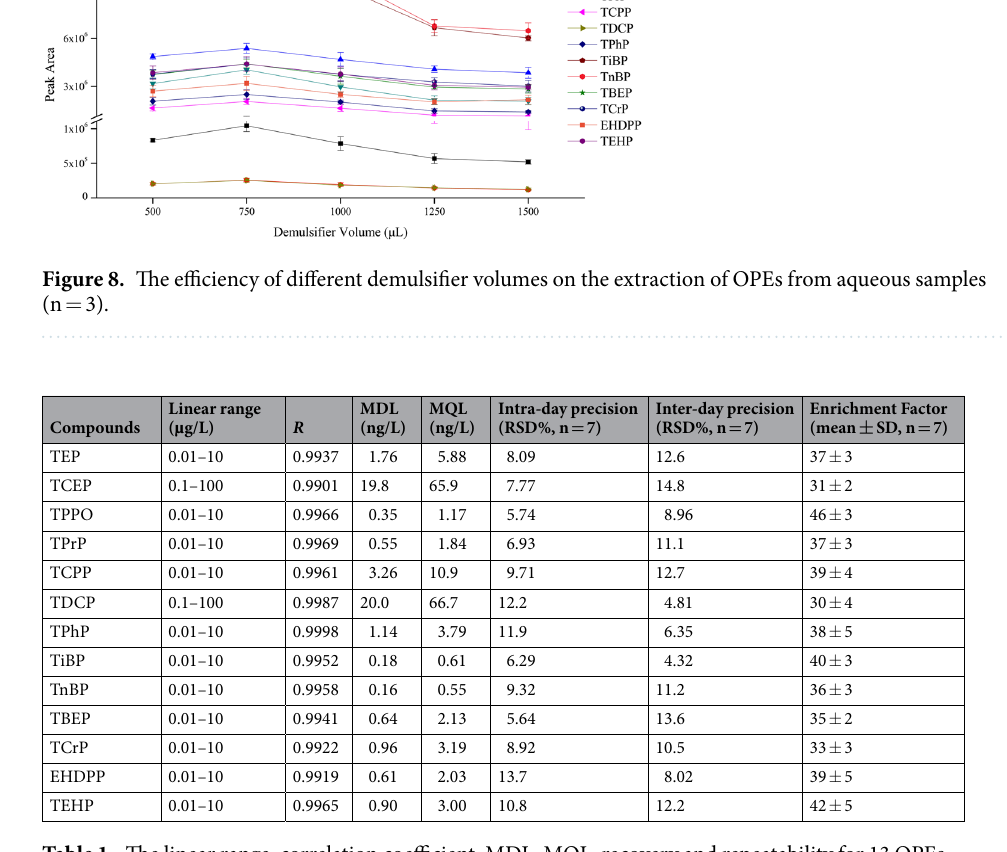
Table 1. The linear range, correlation coefficient, MDL, MQL, recovery and repeatability for 13